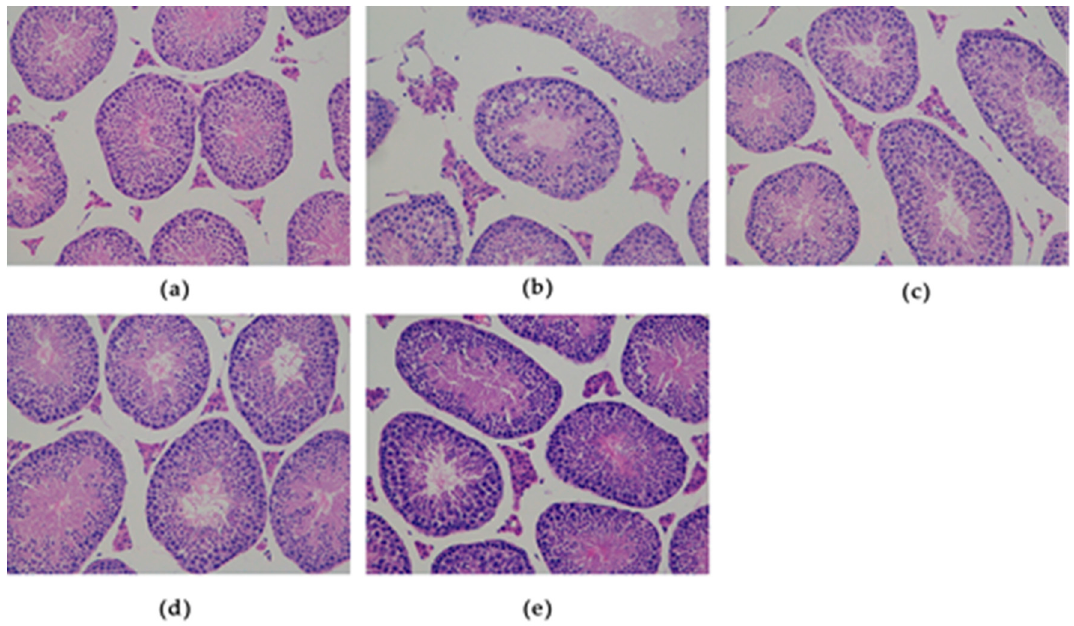
Figure 4. Effects of SFN on the morphology of testis in obese mice: Light microscopic images display the control group ( a ), DIO group ( b ), DIO + SFN 5 mg/kg group ( c ), DIO + SFN 10 mg/kg group ( d ), and DIO + SFN 20 mg/kg group ( e ). For all images: HE staining. Magnification ×40.